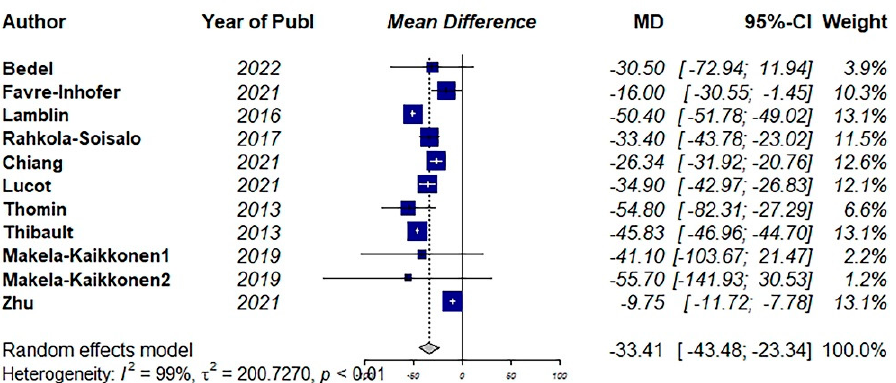
Figure 5. Pooled mean difference of the effect of surgical intervention (vaginal and abdominal surgery) on total quality of life score using Pelvic Floor Impact Questionnaire (PFIQ)